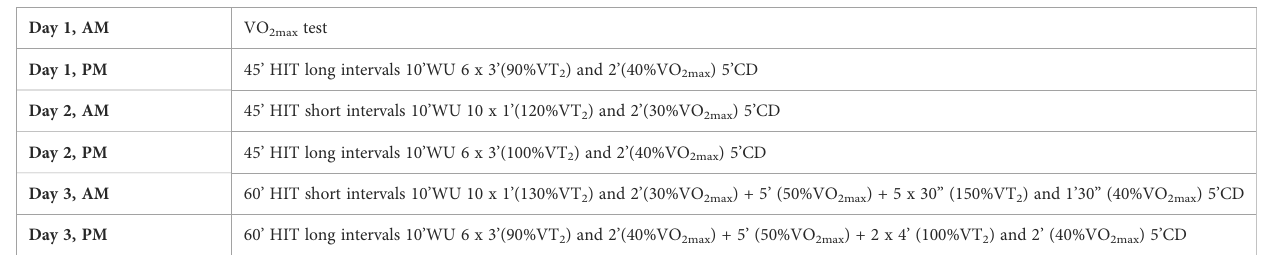
TABLE 1 High-intensity interval training